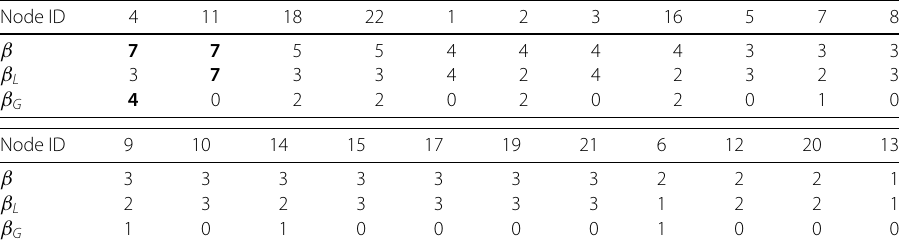
Table 1 Standard Degree centrality, Global and Local Component of the Modular Degree Centrality of the nodes in the toy